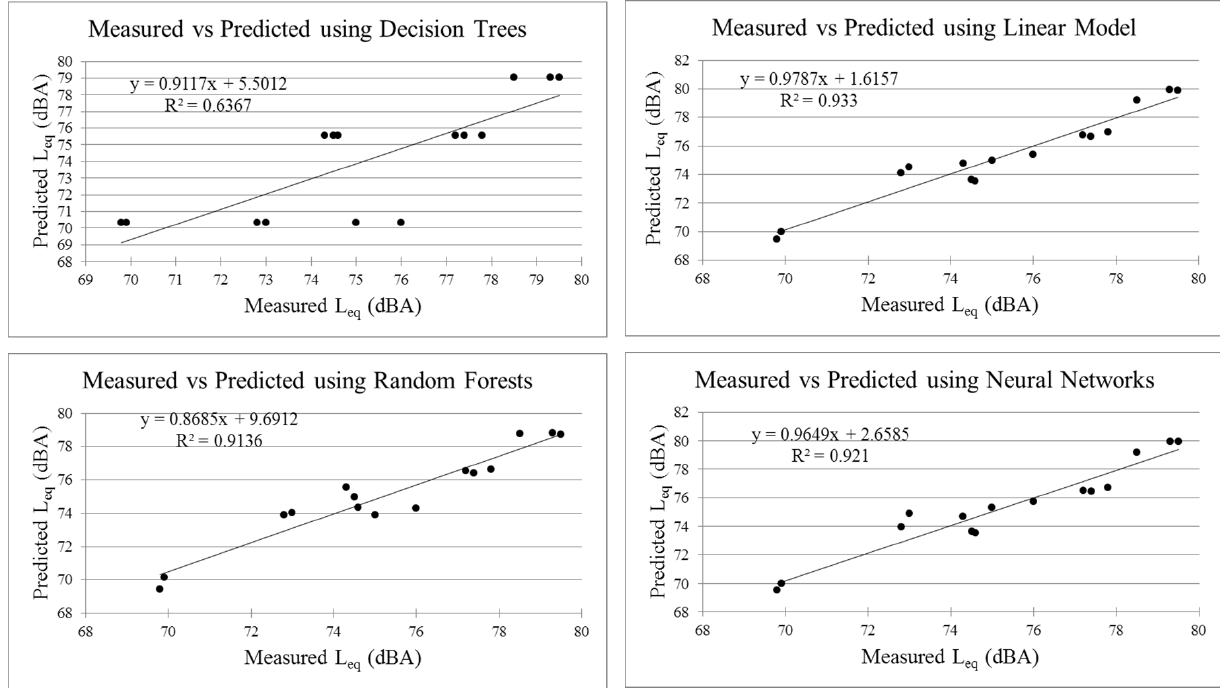
Figure 5. Scatter plots between measured and predicted values of L eq .